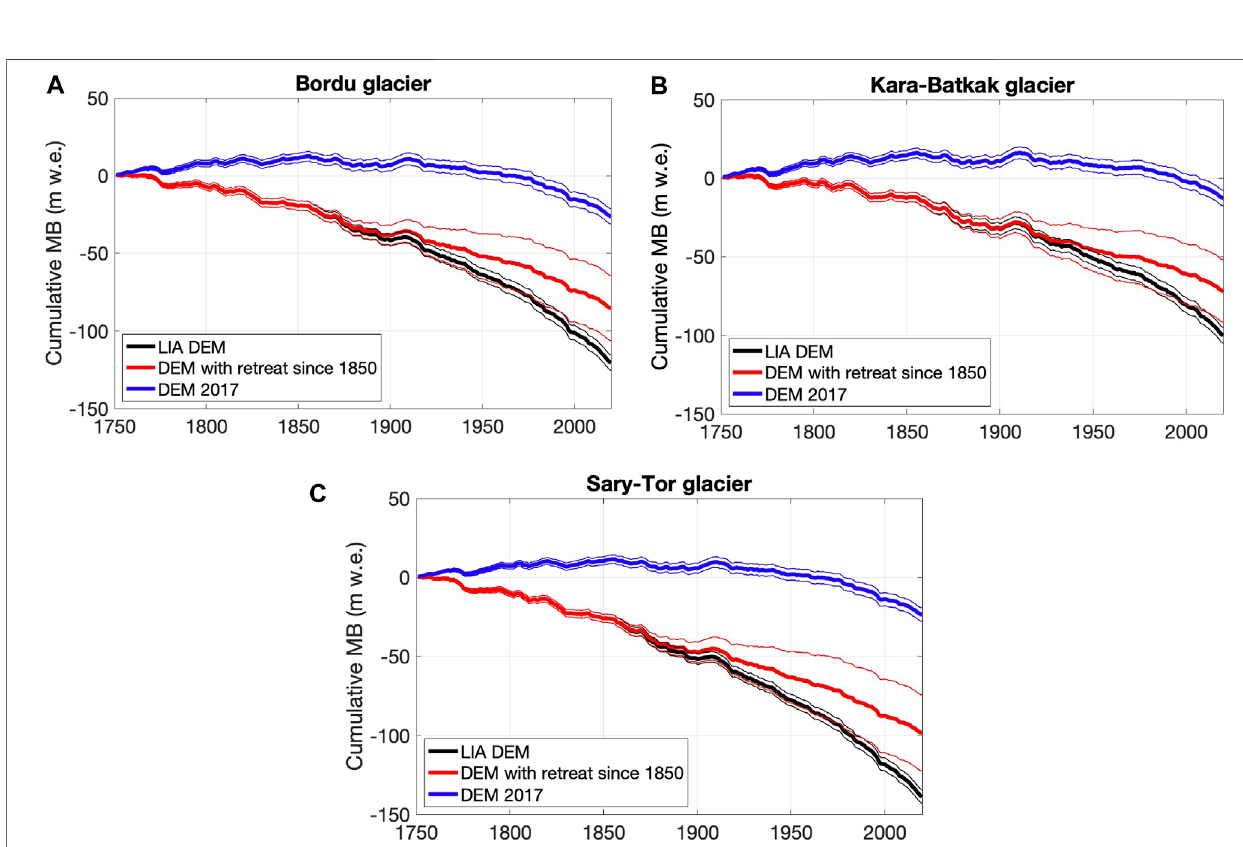
FIGURE 14 | Historical cumulative mean speci fi c mass balance (MB) of Bordu (A) , Kara-Batkak (B) and Sary-Tor (C) glaciers (in m w.e.). The thin lines represent the uncertainty range taking into account uncertainty in model parameter values, meteorological input data and mass balance data for calibration. For the run with the adjusting DEM, also the uncertainty regarding the adjusting geometry was